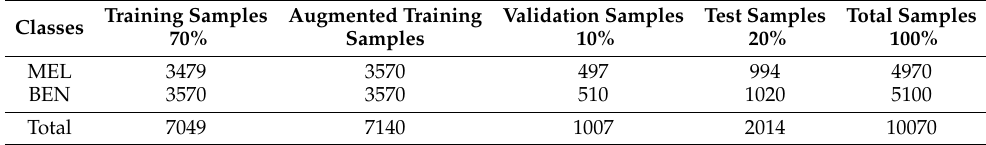
Table 3. The ISIC 2020 data distribution among training, validation, and test